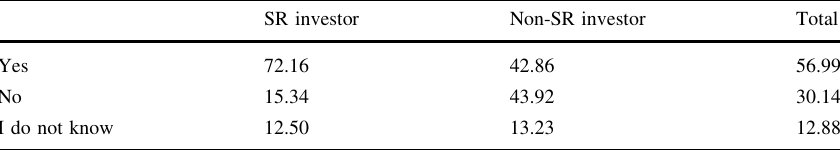
Table 13 Do you think that the major financial crisis in recent years (US housing crisis, euro crisis, and European sovereign debt crisis) could have been prevented or at least reduced by adhering to ethics and sustainability